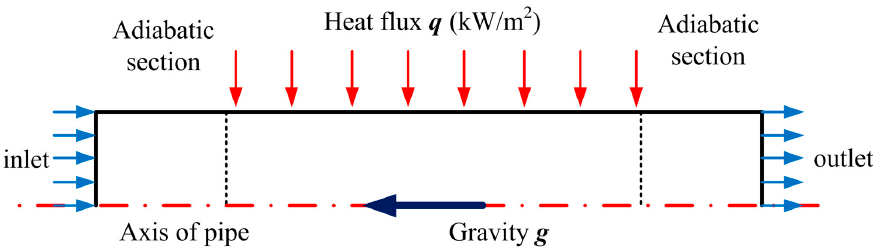
Figure 4. 2-D computational domain and boundary conditions.